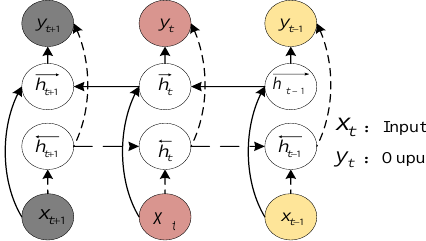
Figure 4. BiLSTM structure diagram.